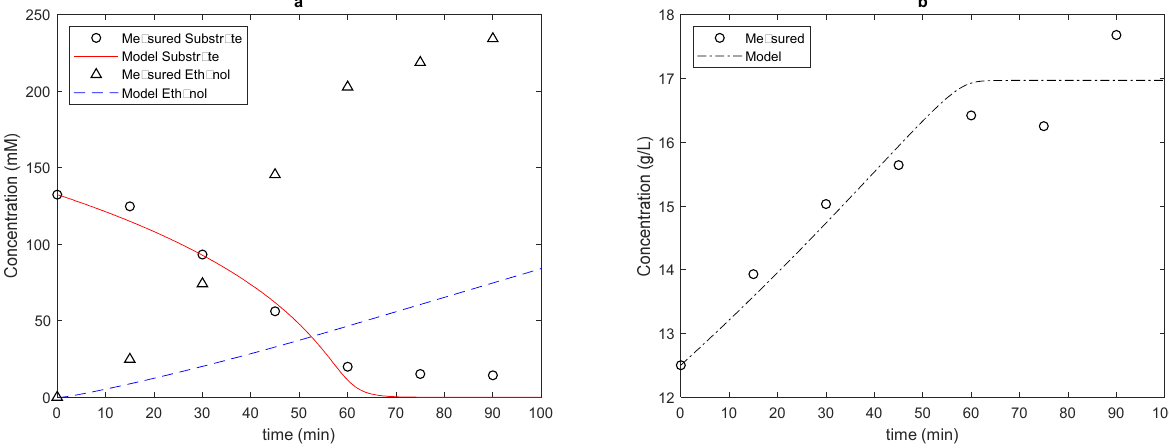
Figure 2. ( a ) SR model result with an initial concentration of 30 g/L, and ( b ) adjustment of cell concentration. Source: prepared by the author.